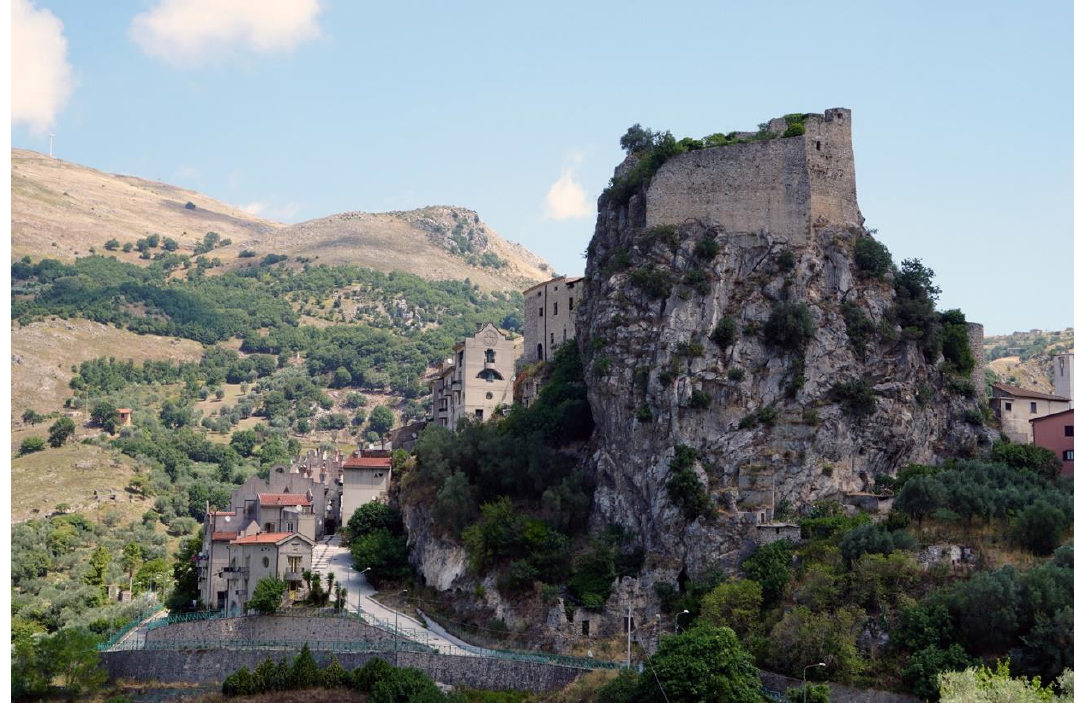
Figure 40. Balvano: Panoramic view with the Castle in the foreground (photos by [35,36]).